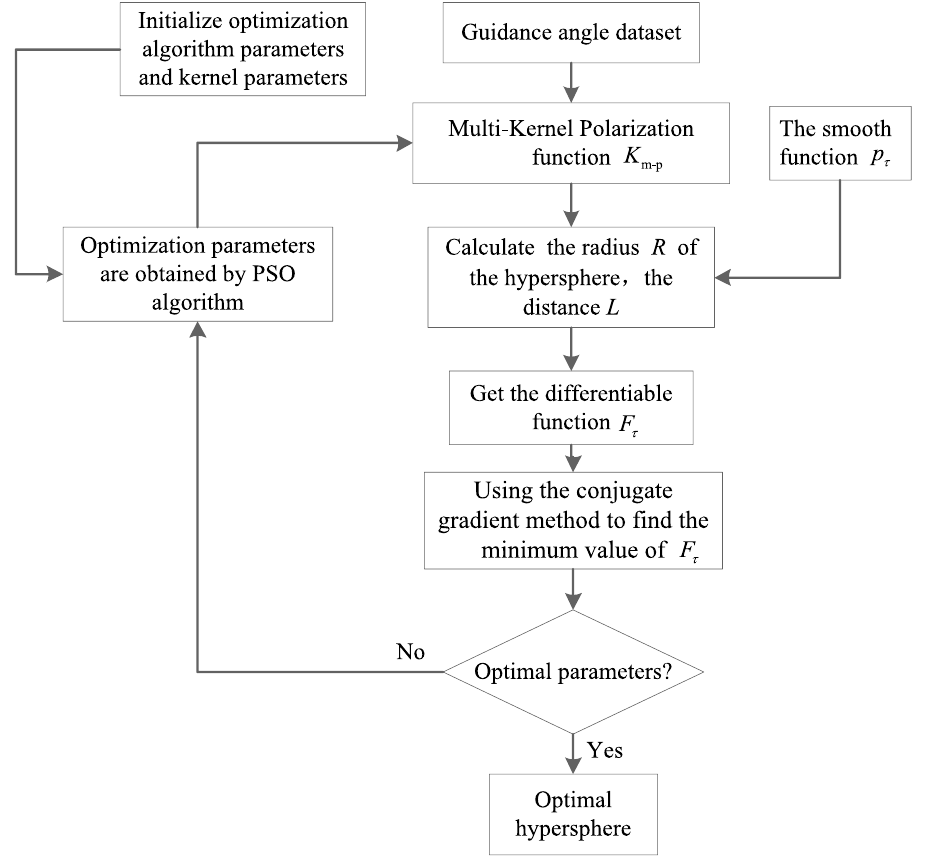
Figure 1. Flow chart of the proposed method in this paper.